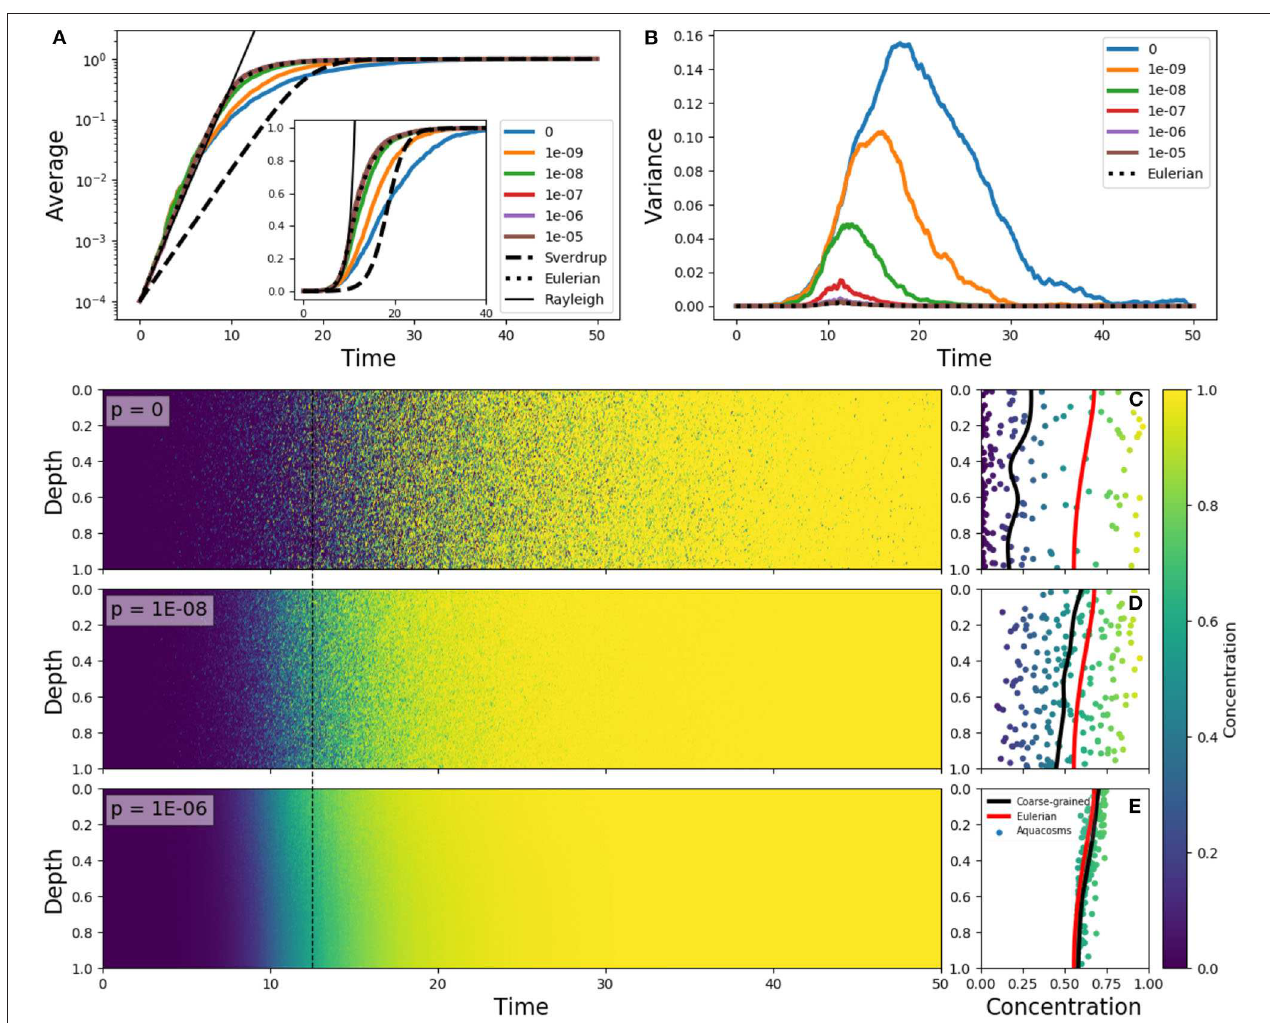
FIGURE 4 | (A) Average phytoplankton concentration and (B) variance as a function of time, for the Eulerian problem (5) with f ( z ) = e − z / 0.15 − 0.1, ε = 10 and constant-in-space initial condition C ( z ) = 10 − 4 (dotted lines). The solid lines in color refer to Lagrangian aquacosm simulations with the same parameters, with varying coupling strength p . The dashed line is the solution of Sverdrup’s approximation (18). The thin black line is an exponential growth with a rate estimated by means of the Rayleigh quotient (section S2 in Supplementary Material) associated to Equation (5). The inset shows the same data as (A) but with a linear, rather than logarithmic, vertical axis. (Lower panels) Plankton concentration as a function of depth and time for Lagrangian simulations with p = 0,10 − 8 ,10 − 6 . (C–E) concentration and depth of the aquacosms (dots), coarse-grained concentration of the aquacosms (black line) and numerical solution of the Eulerian model (red line) at the time marked by the dashed black line in the left